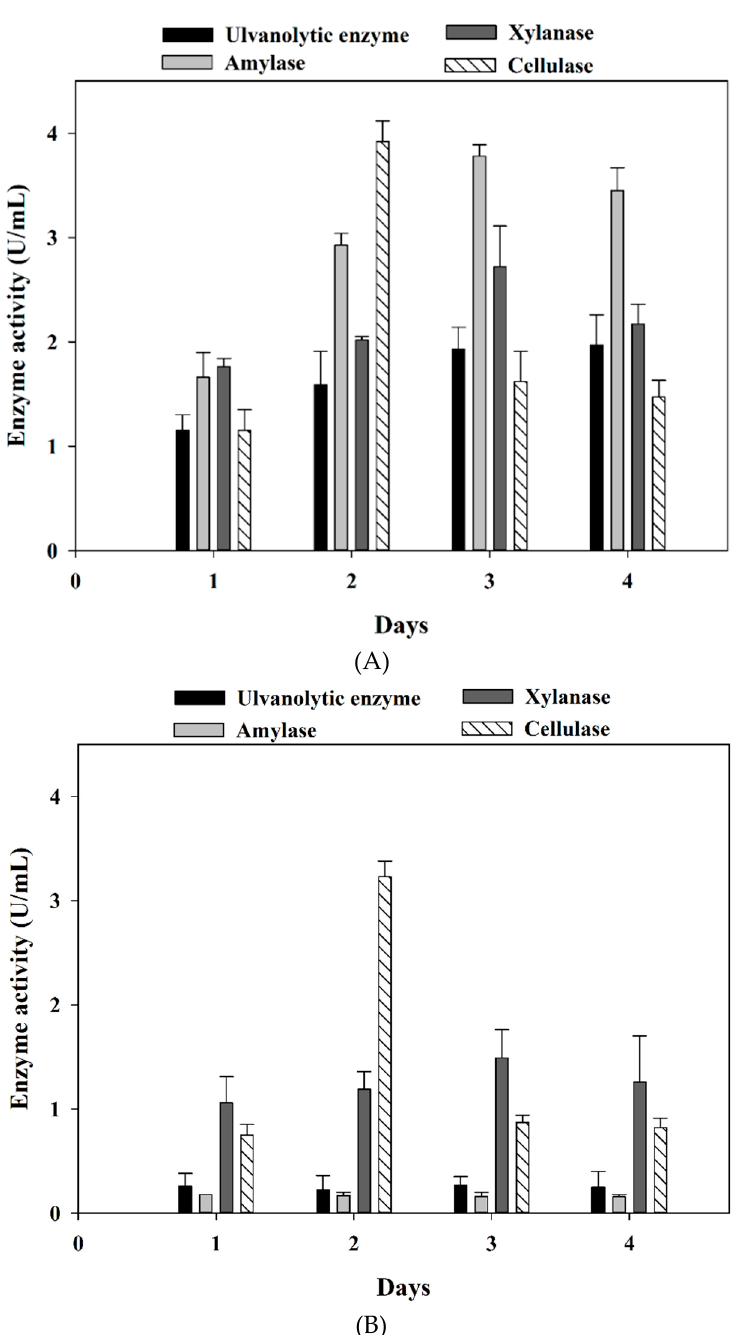
Figure 1. The enzyme activities of the crude enzyme solution from ( A ) P. vesicularis MA103 and ( B ) A. salmonicida